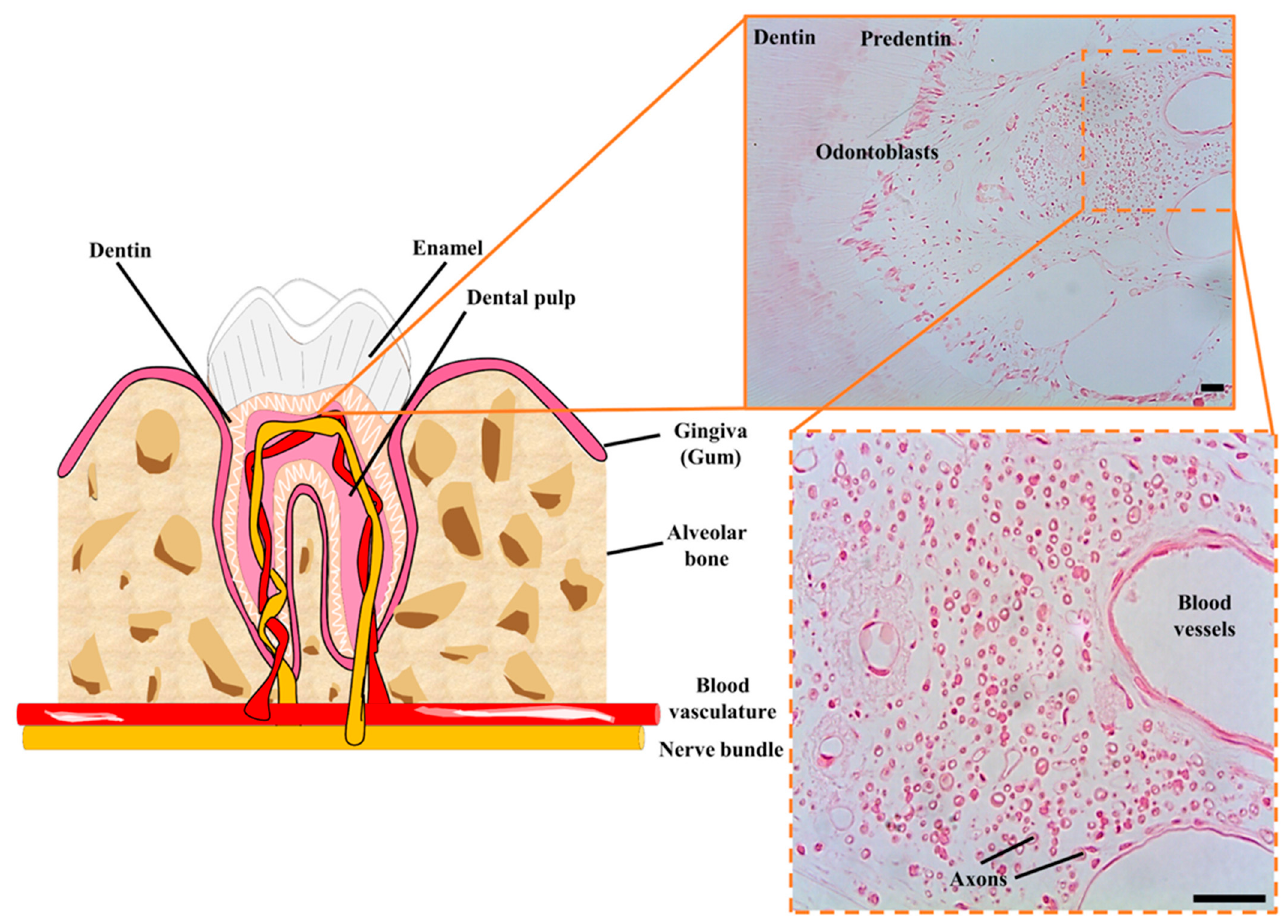
Figure 2. Cellular niche of hDPSCs in postnatal teeth. hDPSCs are harbored in neurovascular bundles of the dental pulp of mature teeth, containing a high concentration of nerve fibers and blood vessels. These neurovascular niches contain many myelinated axons (shown in cross ‐ section) and a higher cellular density than in the rest of the dental pulp tissue. Scale bars: 50 μ m.